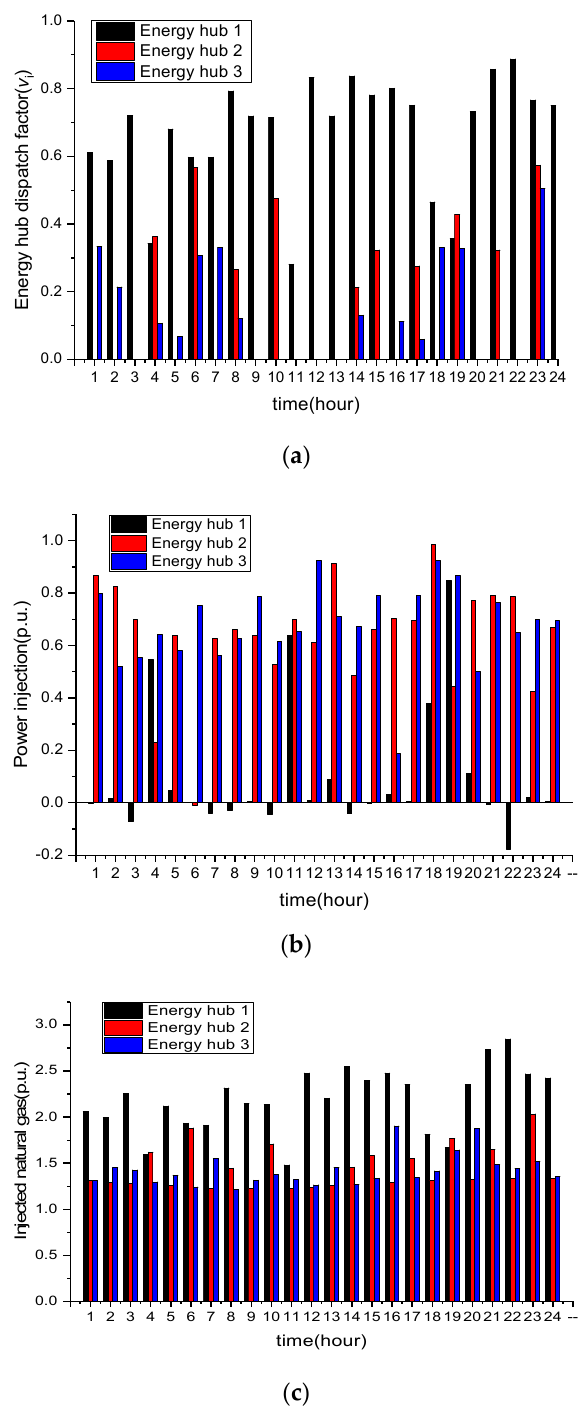
Figure 6. System variables of three energy hubs’ change in 24 h: ( a ) Scheduling factor; ( b ) input electricity; ( c ) input natural